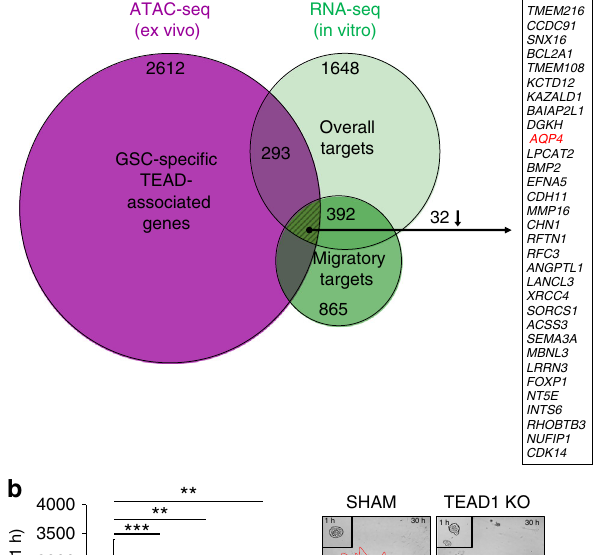
Fig. 7 TEAD1 regulates GBM migration by modulating AQP4 expression. a Venn diagram depicts the intersection of genes with TEAD motifs and genes consistently downregulated in TEAD1KO cell lines and migration- de fi cient spheroids (striped area). AQP4 is the only one of 32 genes in this intersection found to be a direct TEAD1 binding target in vivo (highlighted in red). ATAC-seq set contains 2612 peak-annotated genes from E + GSC vs. E − GBM + NSPC differential accessibility analysis. Top RNA-seq set (overall targets) contains all 1648 signi fi cantly up or downregulated genes from TEAD1KO vs. Sham differential expression analysis in all samples from four different patient-derived GBM lines and three migration experiments ( n = 7; p adj. < 0.05; all log2(fold change) values of HGNC-annotated genes included). Bottom RNA-seq set (migratory targets) contains 865 signi fi cantly up or downregulated genes from TEAD1KO vs. Sham G- 13063 spheroids from three independent migration experiments ( n = 3; p adj. < 0.05; log2(fold change) >1 or < − 1). See also Supplementary Fig. 7. b Spheroid migration assay showing signi fi cant reversal of cell dispersion de fi cit at 30 h in TEAD1 knockout cells after overexpression of CDH11 or AQP4 (G-13063 line; laminin + PDL substrate; n = 3 wells. TEAD1KO + CDH11OE: ** p = 0.004; TEAD1KO + AQP4OE: ** p = 0.0015. Bars represent mean ± SEM). On right, migration area marked by red dash line in representative spheroids is shown. Scale bar = 75 μ M. c Quanti fi cation of AQP4 expression by RT-qPCR. AQP4 is signi fi cantly upregulated in TEAD1KO cells after TEAD1 overexpression ( n = 6, 4 technical and 2 biological replicates; * p = 0.02 TEAD1KO + TEAD1OE vs. TEAD1KO) and is robustly expressed after exogenous lentivirus overexpression. Bars represent mean ±